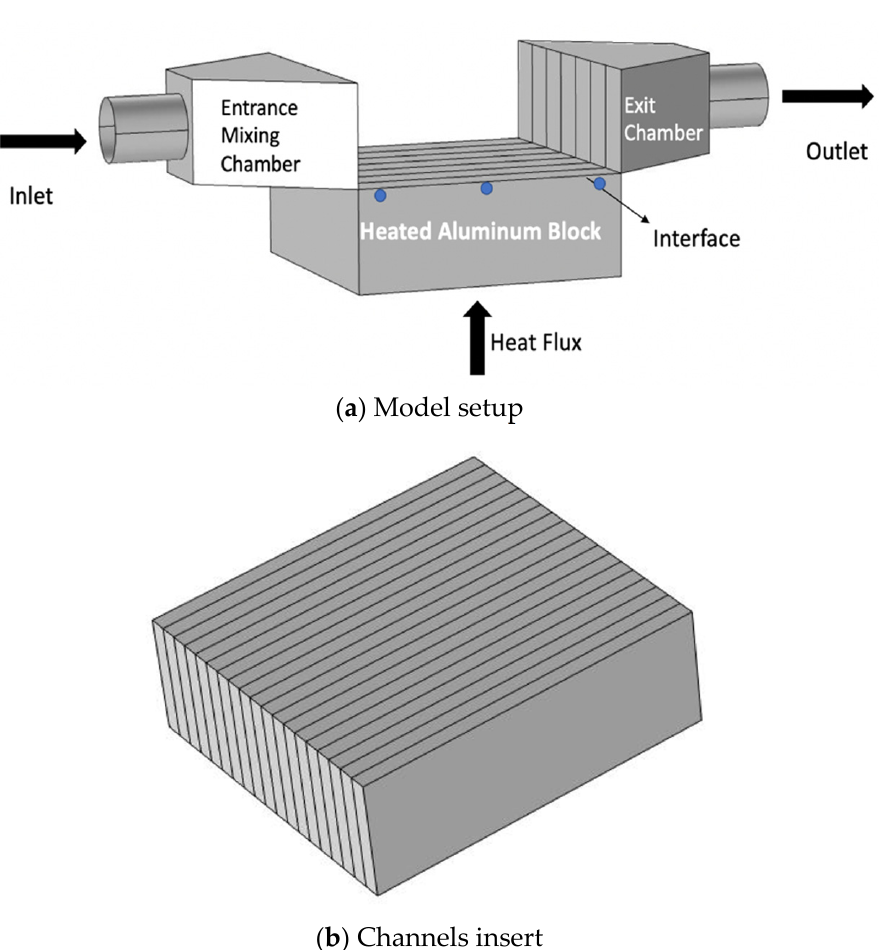
Figure 1. A geometrical model with a different insert. ( a ) Experimental setup. ( b ) Insert mini channels. The pressure drop for the friction factor is measured at the entrance and exit of the mixing chamber. Thus, it is the pressure drop for the entire insert. Using the average velocity, we calculated the friction factor along the flow direction (Z-direction) for the entire setup. Constant heat flux is applied at the bottom of the setup of 50,000 W/m 2 and, in non-dimensional form, is equivalent to 1. Our working fluids are water and 1% vol Al 2 O 3 /water, with two different nanoparticle diameters of 31 nm and 100 nm. Table 1 presents the physical properties of these nanofluids for different nanoparticle sizes. Table 1. Physical properties of the nanofluids [33]. Fluids